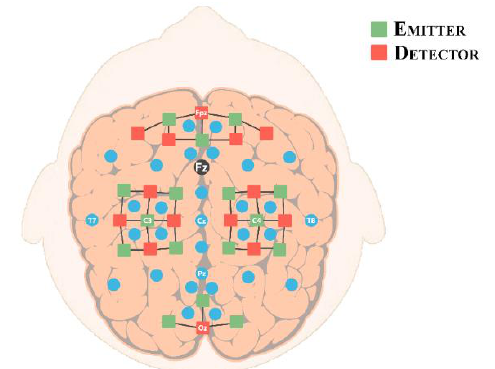
Figure 2. Optodes were placed at the frontal, motor, and visual cortex following the 10–20 international system [45]. Green and red squares represent emitters and detectors, respectively. Fourteen emitters and sixteen detectors were used to record functional near-infrared spectroscopy (fNIRS) signals with separation of 3 cm, resulting in a total of